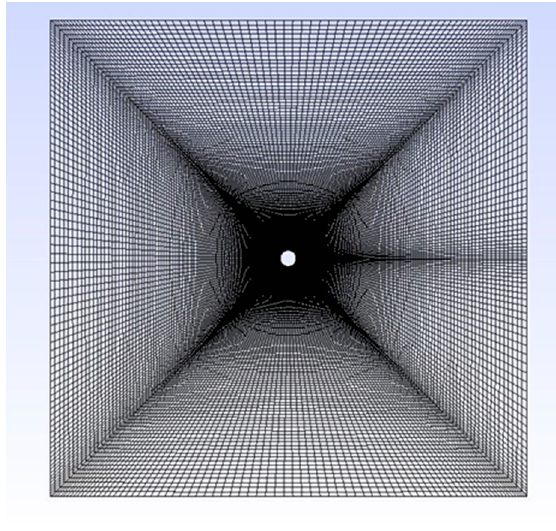
Figure 13. Structured grid around a circular cylinder.